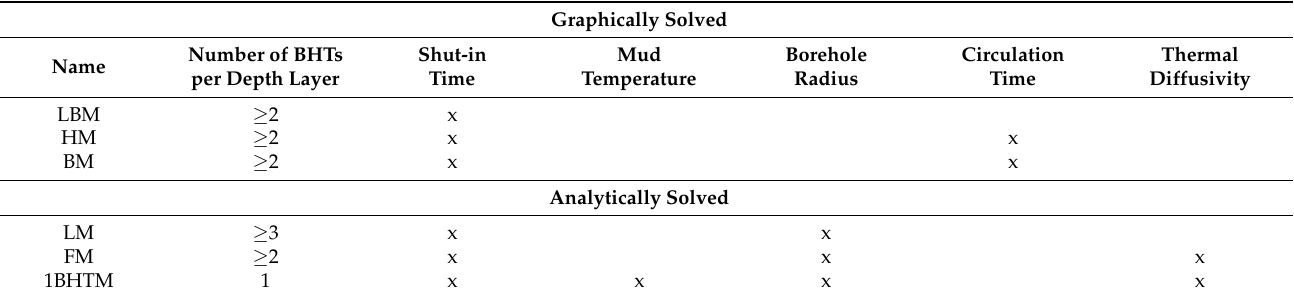
Table 2. Input requirements (marked with x) of six conventional BHT correction methods. Graphically